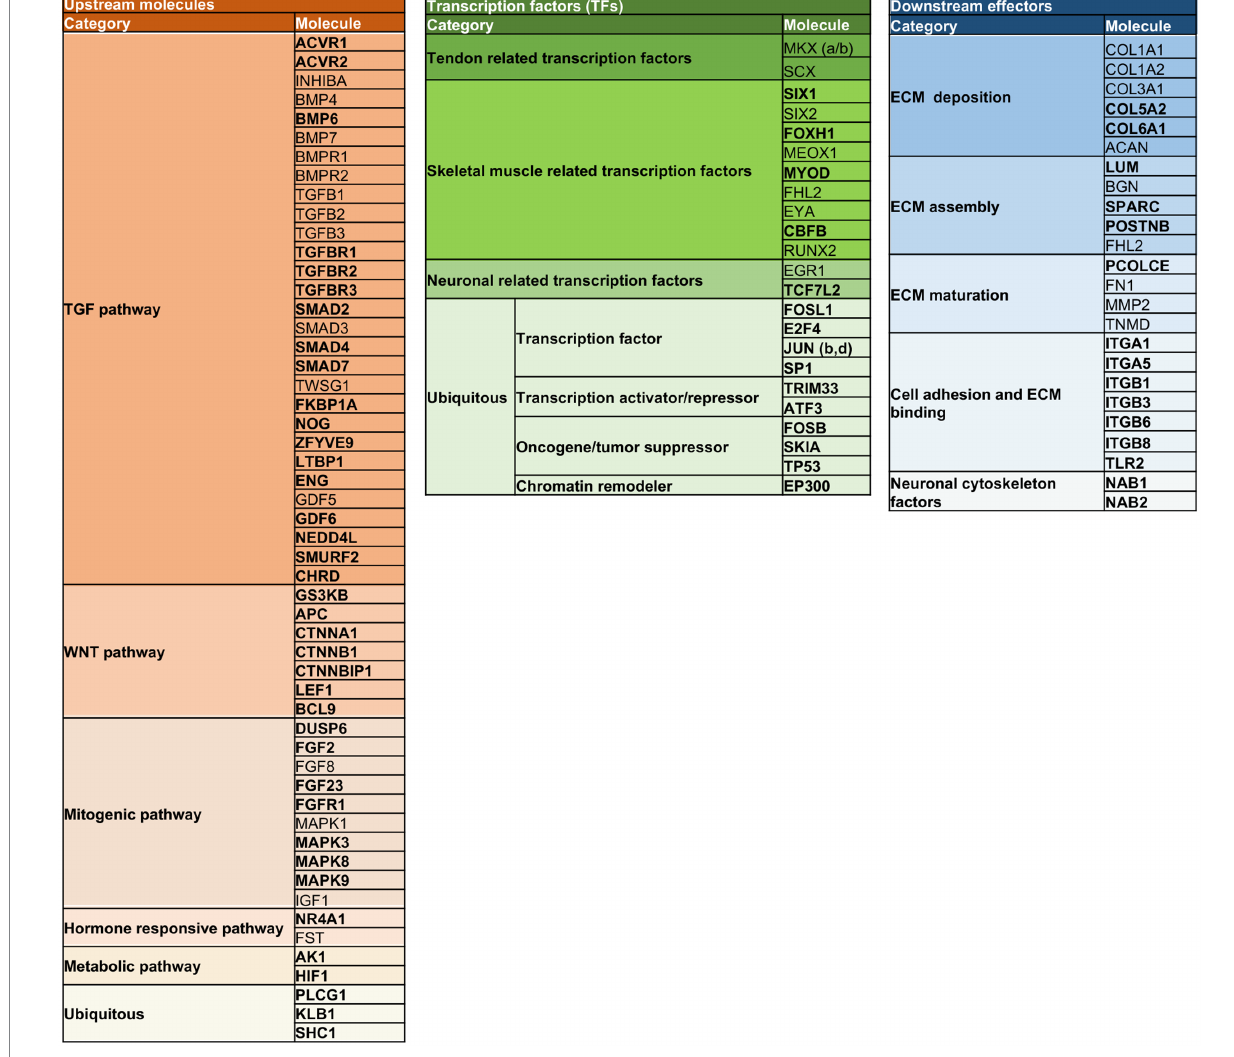
FIGURE 8 Multi-layered organization of the overall molecules composing the TendonNETs and the StringNETs. New molecules identified by STRING have been reported in bold. The different colors of the nodes allow to identify the signaling layer of pertinence. In orange were reported nodes of the upstream layer; in green nodes of the TF layer, and in light blue nodes of the downstream